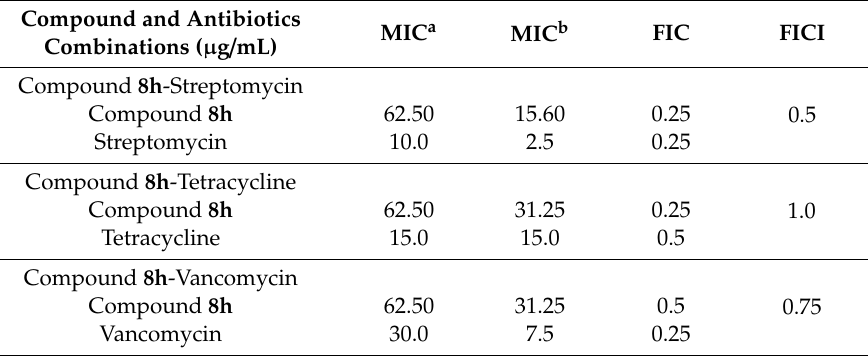
Table 3. FIC and FICI of streptomycin, tetracycline, and vancomycin combined with the compound 8h of against Escherichia coli ATCC